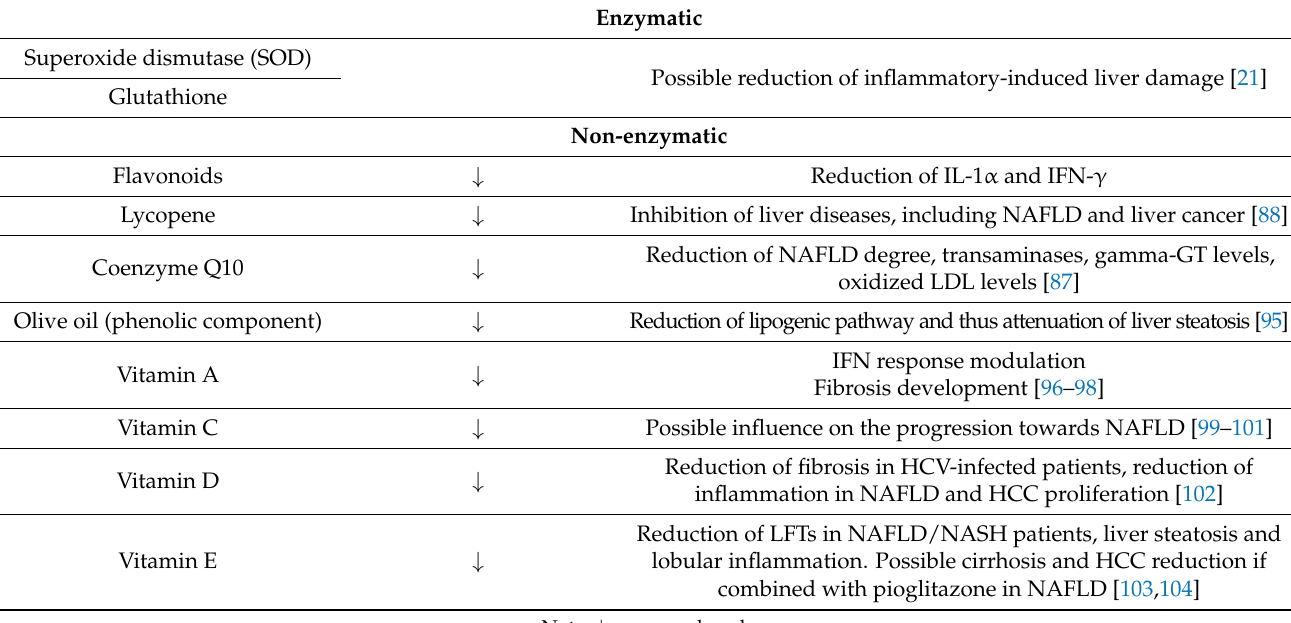
Table 2. Enzymatic and non-enzymatic antioxidants and their role in NAFLD.